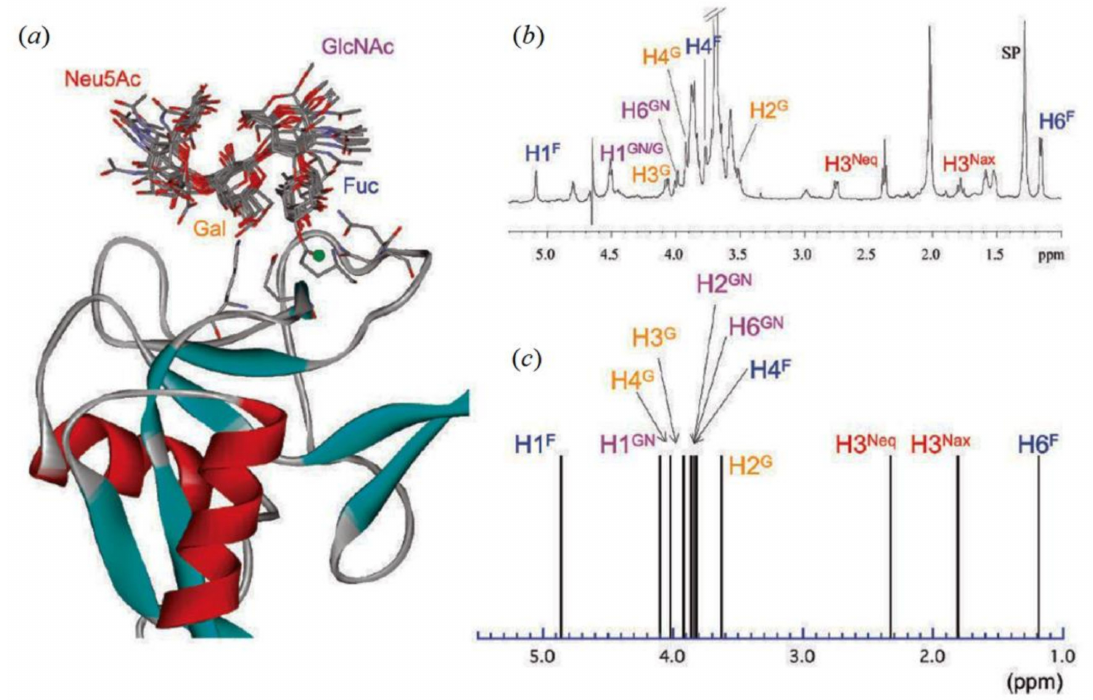
Figure 51. ( a )—Superimposed geometries of a sialyl Lewis X complex at the carbohydrate-recognition domain. Ten QM/MM optimized structures of SLe x are superimposed onto one reference structure. Only the SLe x structures are shown by the stick model. Right panels: ( b )—Experimental NMR profile. ( c )—Computed 1D proton chemical shift profile of the SLe x ligand. Reproduced from Ishida [165] with the permission of the American Chemical